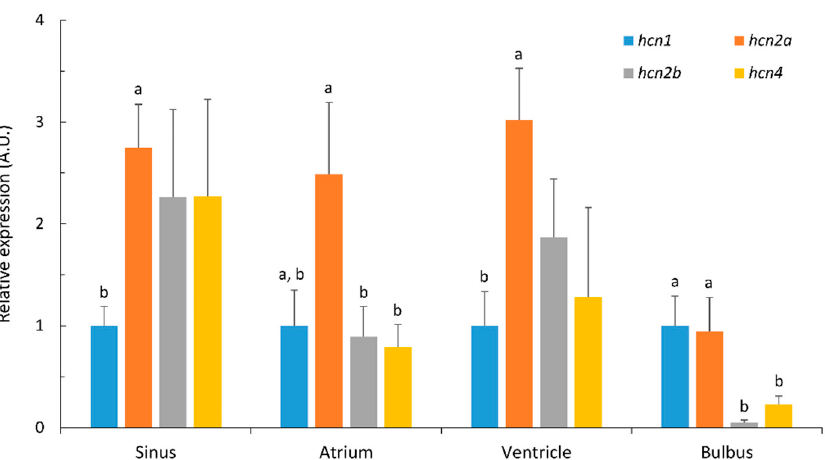
Figure 2. Relative expression levels of hcn1 , hcn2a , hcn2b and hcn4 in sinus, atrium, ventricle and bulbus arteriosus in Atlantic cod. Transcripts were quantified by qPCR, normalized using the geometric average of ubi and eef1 expression and shown as relative values compared to hcn1 transcript levels in each sample. Data are expressed in arbitrary units (A.U.) as mean ± S.E. ( n = 5). Different superscript letters ( a, b ) indicate significant differences in transcript levels between hcn paralogues in each heart region. Differences in hcn transcript levels within each heart area were determined by one-way ANOVA with a Holm–Sidak post hoc test ( p < 0.05). Kruskal–Wallis one-way ANOVA on ranks with Dunn’s post hoc test was performed when the data did not meet the normality and equal variance requirements.